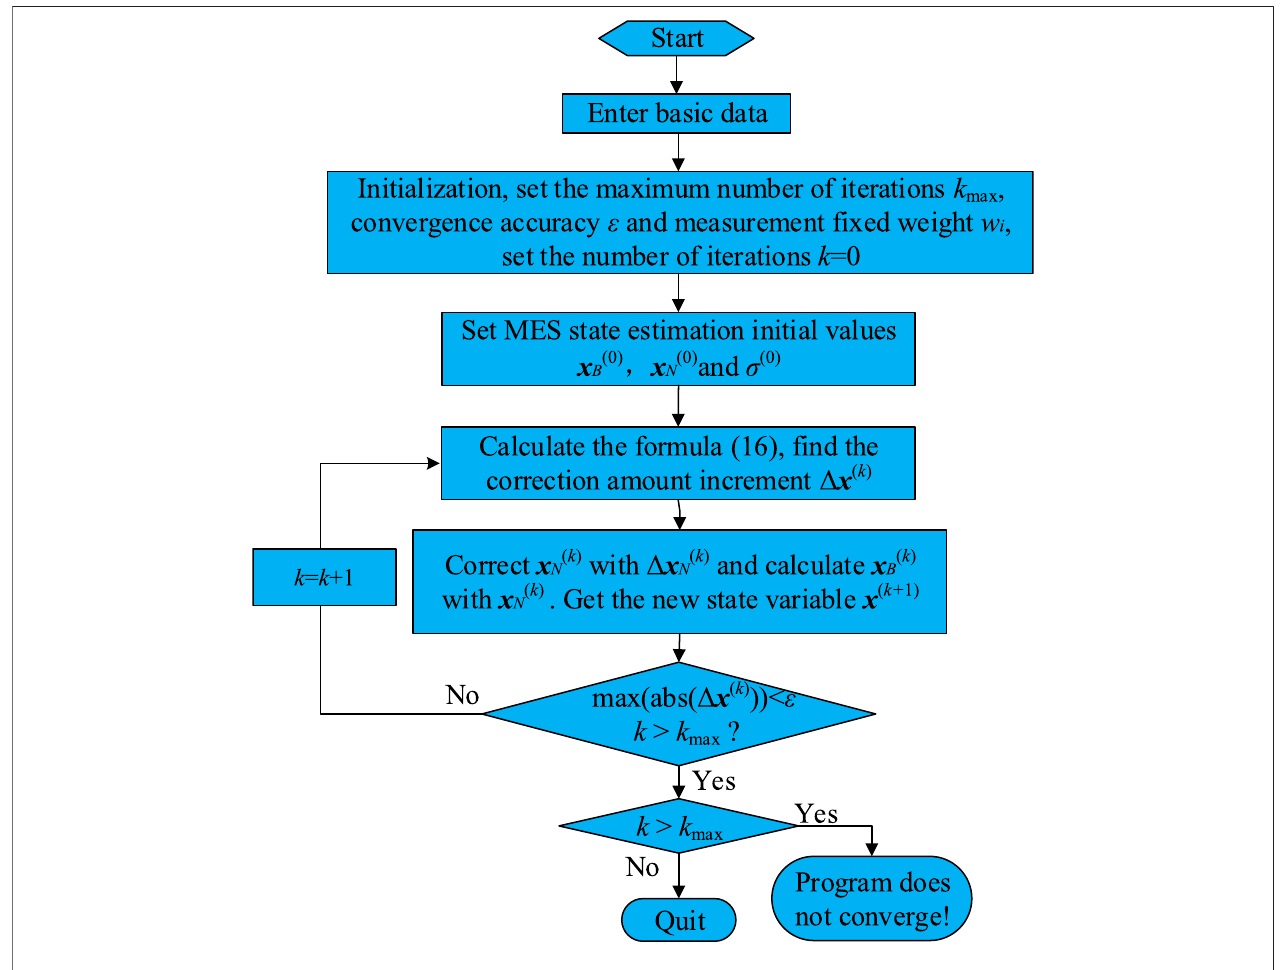
FIGURE 1 | MES calculation fl